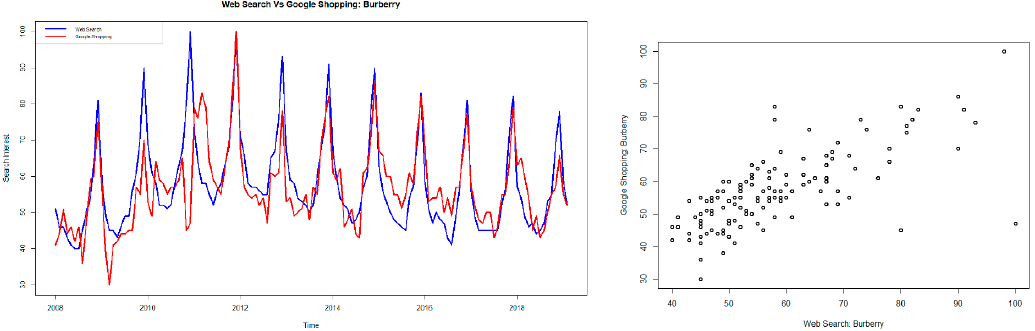
Figure 13. Time series plot and scatterplot for Burberry fashion consumer Google Trends: web search vs. Google shopping (Data Source: Google Trends, 14 March 2019).